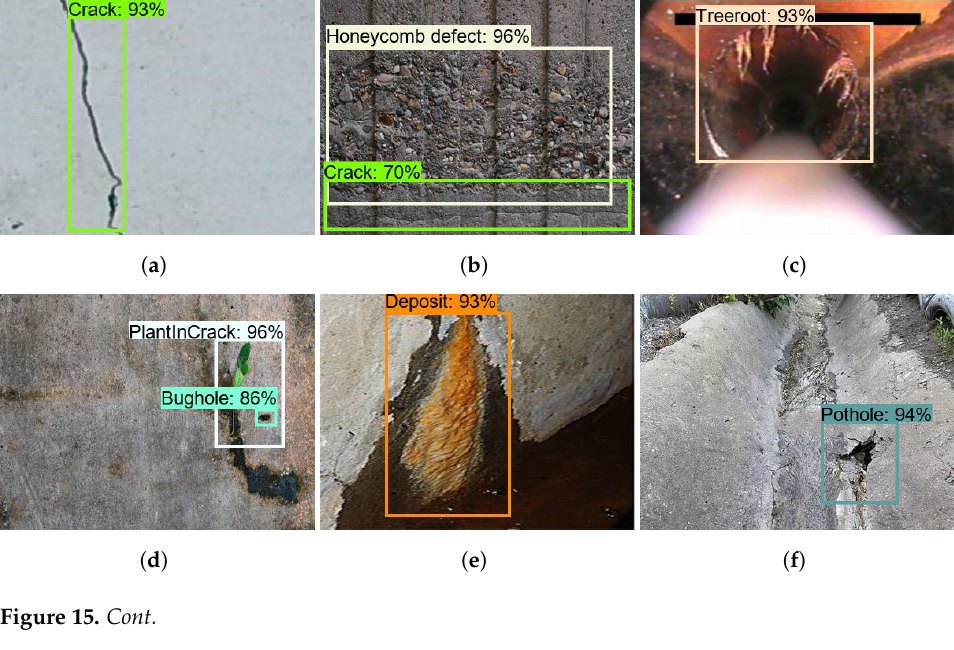
Figure 14. ResNet101 defect detection results. ( a ) Crack; ( b ) Honeycomb defect; ( c ) Tree root intrusion; ( d ) Plant intrusion; ( e ) Deposit; ( f ) Pothole; ( g ) Bughole; ( h ) Crack.